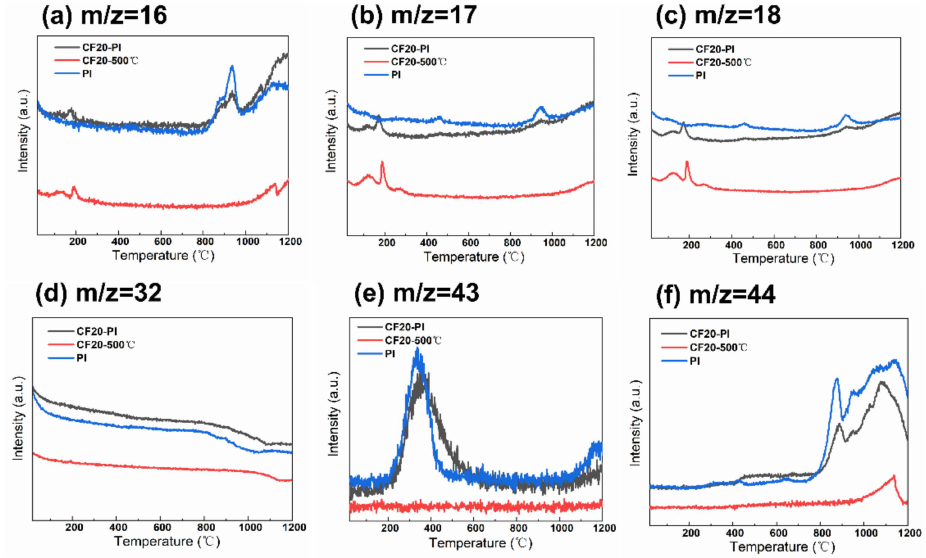
Figure 6. Weight spectrometry images of polyimide aerogels, pre-carbonized foams and